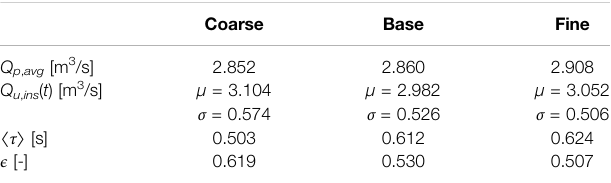
TABLE 2 | Summary of ventilation measures obtained using the coarse, medium, and fi ne meshes.